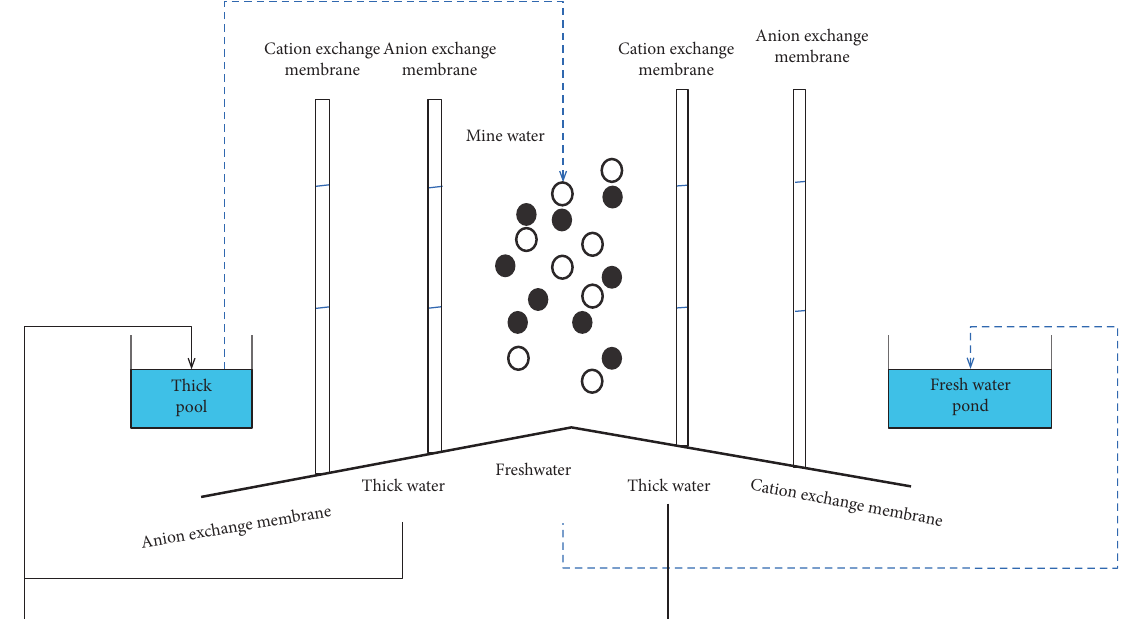
Figure 3: Schematic diagram of ion